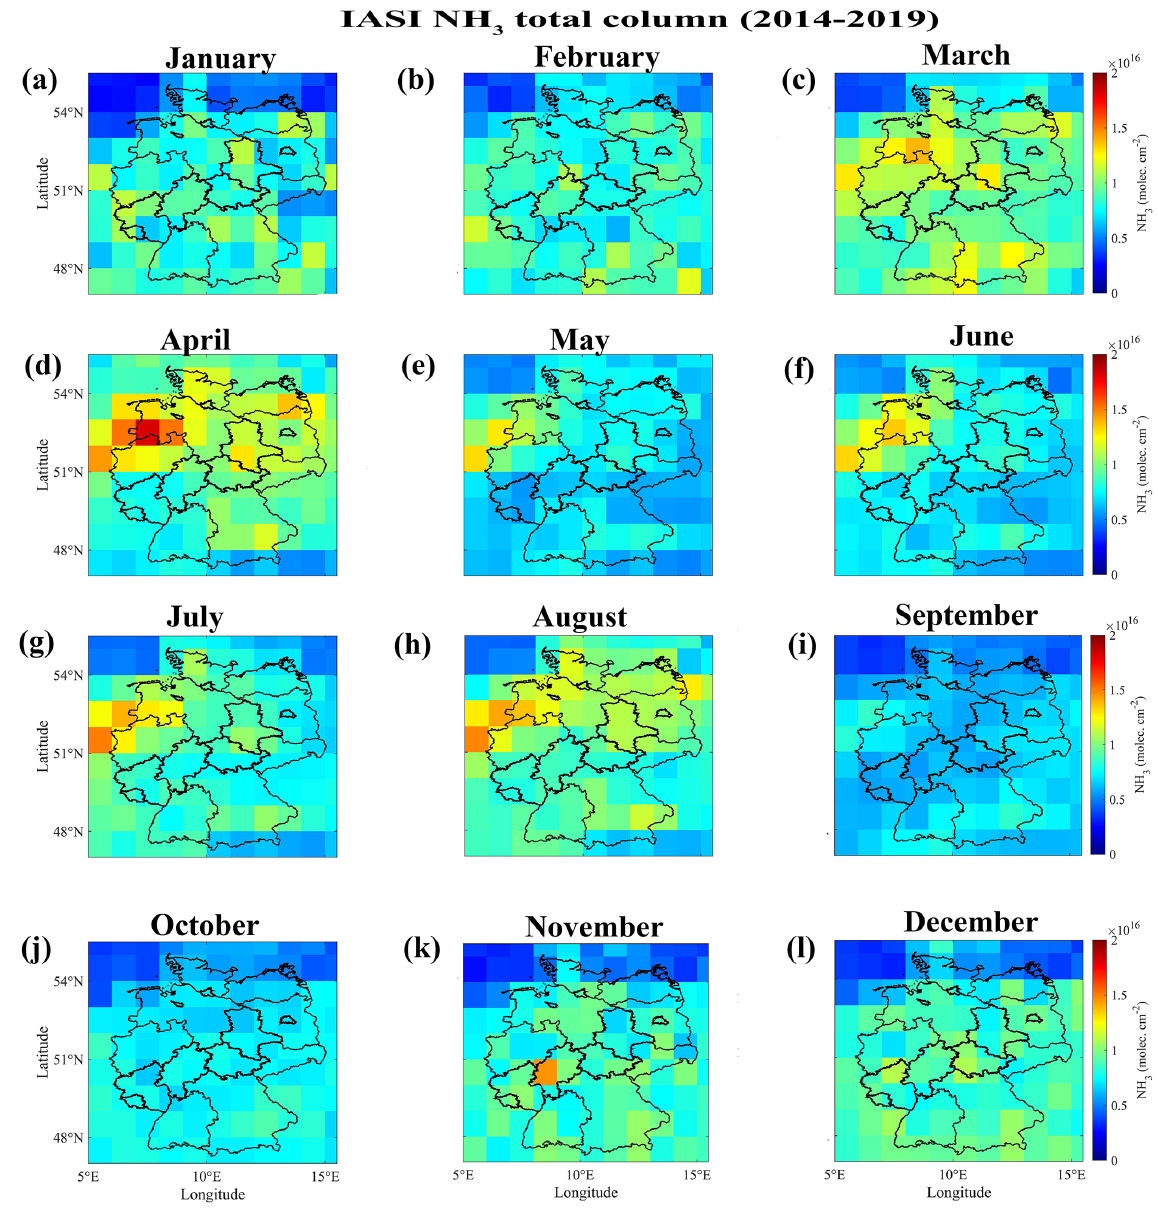
Figure 6. Monthly mean IASI NH 3 total column at 1 ◦ × 1 ◦